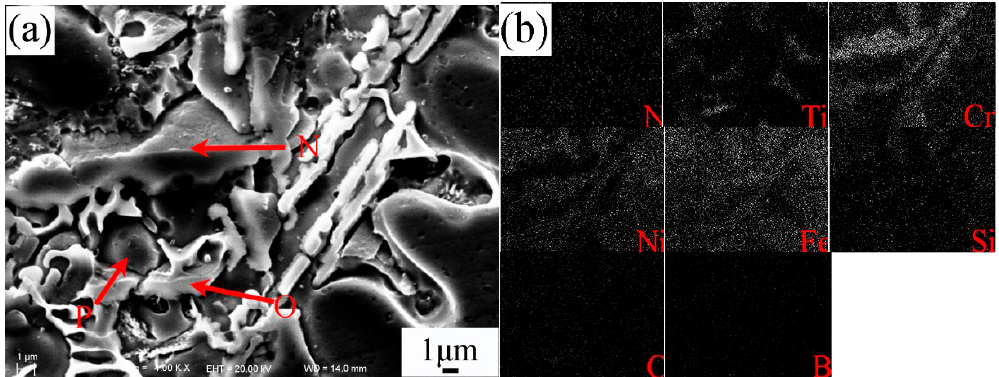
Figure 7. Magnification of area K in Figure 5 and area scan of Figure 5a. ( a ) SEM of magnified dendrite grains of the coating ( b ) The chemical elements in specimen No.2. Table 6. EDS analysis results of different points in Figures 5–7 (at %).